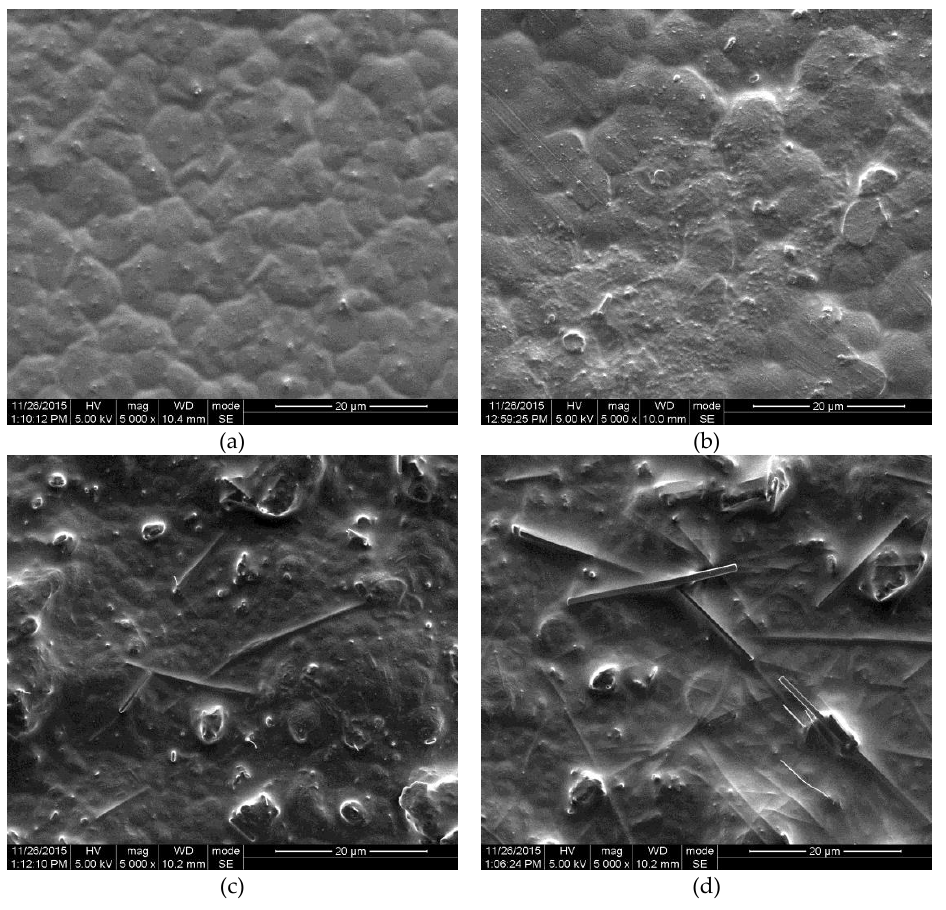
Figure 2. Surface morphology of nanocomposite films with ( a ) 0 wt %, ( b ) 10 wt %, ( c ) 20 wt % and ( d ) 25 wt % PMN-PT nanorod content.